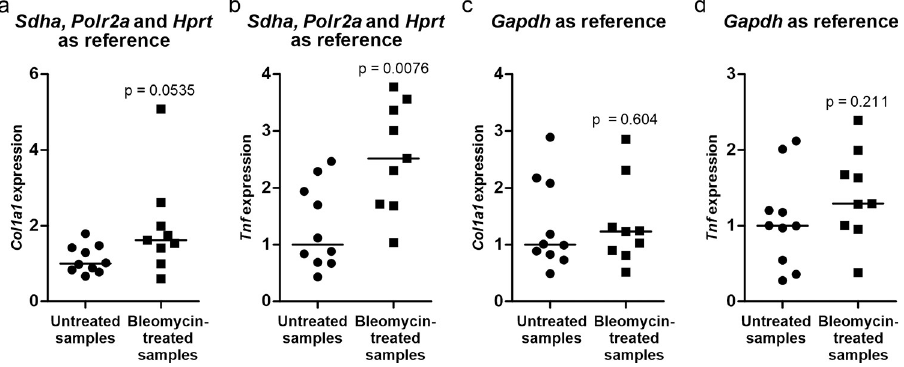
Fig 5. Validation of selected normalization strategies. Changes in the expression of Col1a1 (a, c) and Tnf (b, d) in bleomycin-treated mice (square points) relative to untreated mice (round points) when Sdha , Polr2a and Hprt are used as reference genes (a, b) and Gapdh as reference (c, d). Lines at medians. n = 9–10. Mann-Whitney U test.